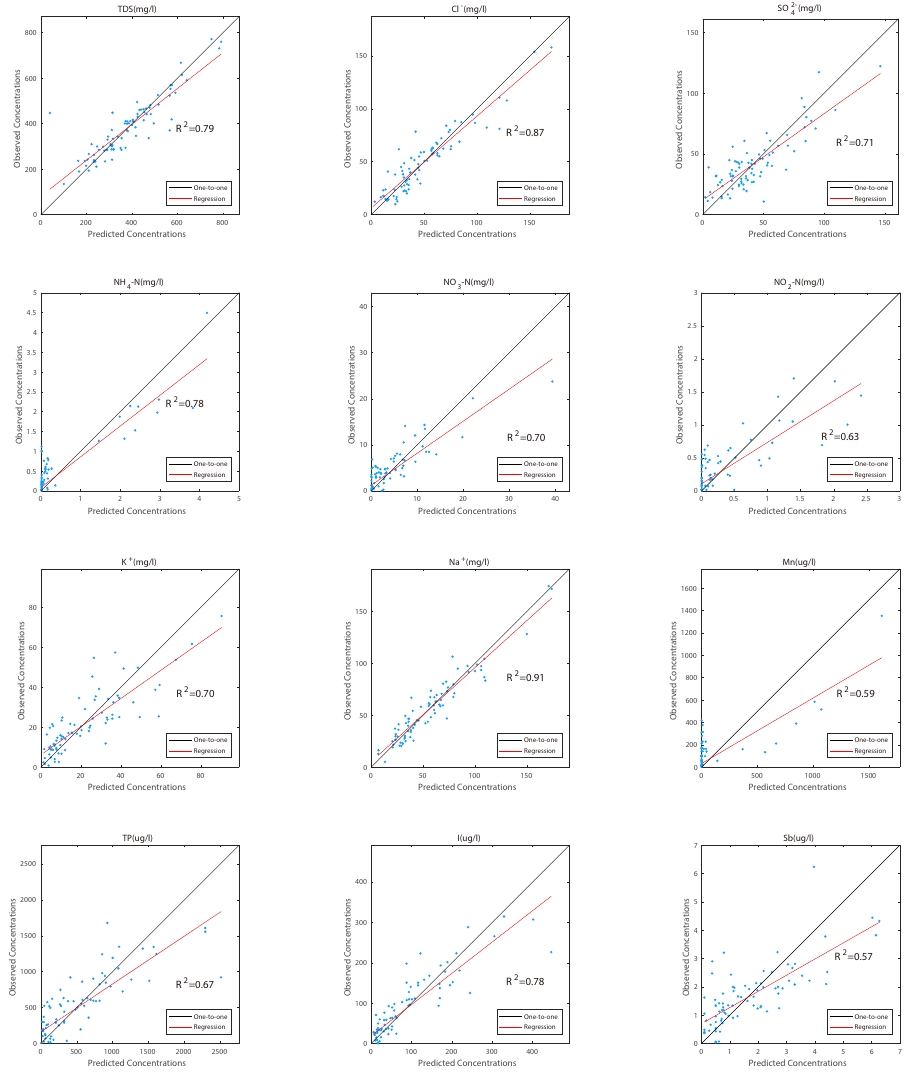
Figure 7. Scatter plots of the predicted and observed concentrations for main groundwater pollutant parameters by using APCS-MLR